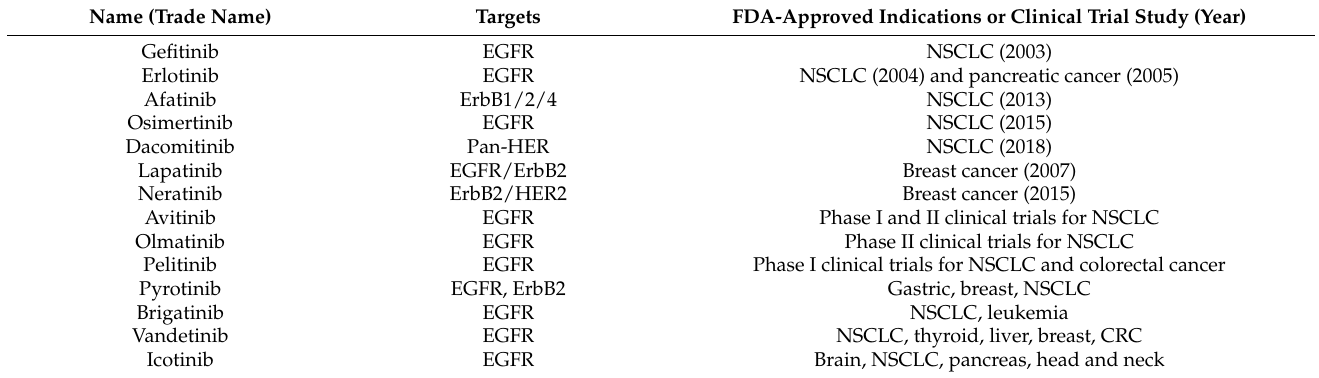
Table 3. Properties of selected orally effective small-molecule EGFR family inhibitors